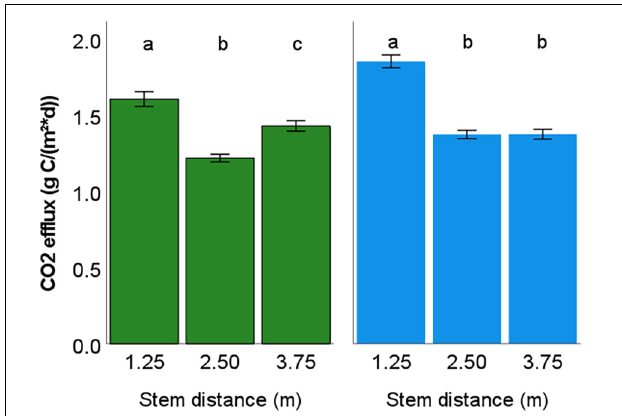
FIGURE 6 | Mean annual CO 2 efflux of the beech site (left) and the pine site (right) at different stem distances including error bars ± 2 standard error units (SE). Different letters indicate significant differences in CO 2 efflux between the stem distances according to Friedman’s test ( p < 0.05).